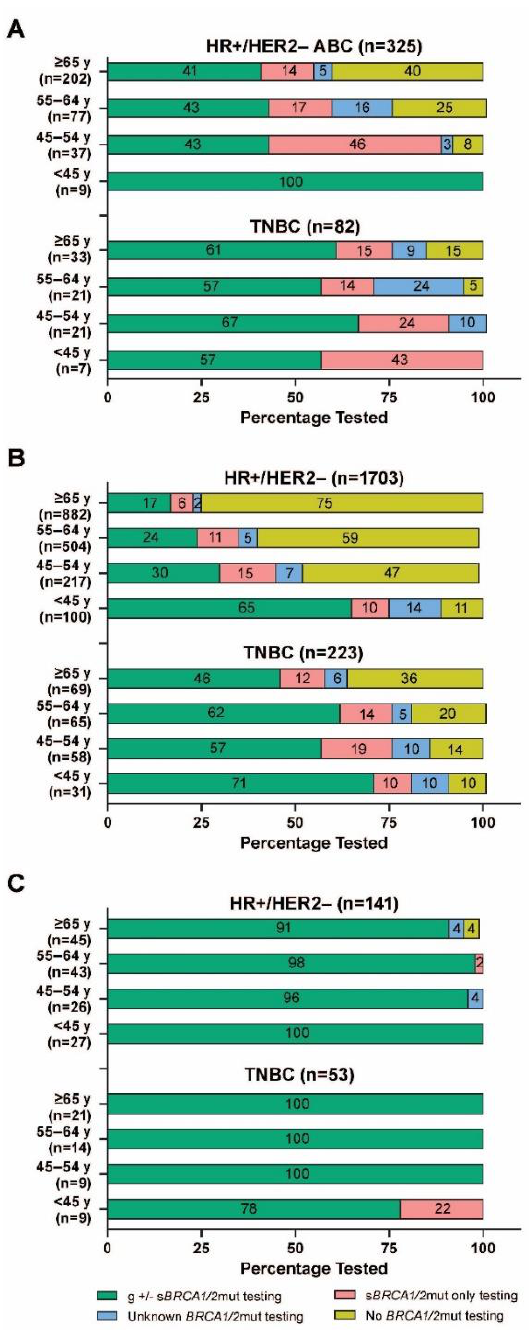
Figure 2. BRCA1/2 mut testing rates by age group among patients with HER2 − ABC in ( A ) the United States, ( B ) the EU4, and ( C ) Israel. Percentages may not add to exactly 100 because of rounding. ABC = advanced breast cancer; BRCA1/2 mut = breast cancer susceptibility gene 1 or 2 mutation; g = germline; EU4 = European Union 4 (France, Germany, Italy, and Spain); HER2 − = human epidermal growth factor receptor 2–negative; HR+ = hormone receptor–positive; s = somatic; TNBC = triple-negative breast cancer. Among US patients with HR+/HER2− ABC tested for any BRCA1/ 2mut, 36% received genetic counseling (73 [91%] from a genetic counselor and 8 [10%] from the treating phy- sician), 52% did not receive counseling (received vs. did not receive counseling: binomial